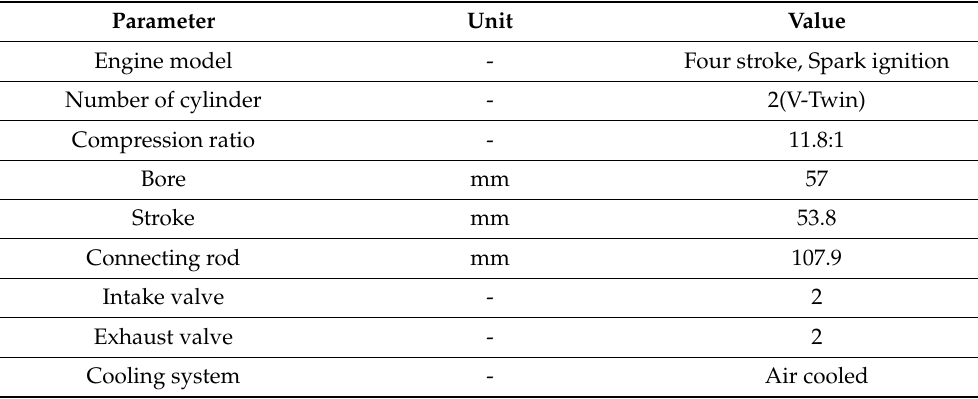
Table 1. The engine